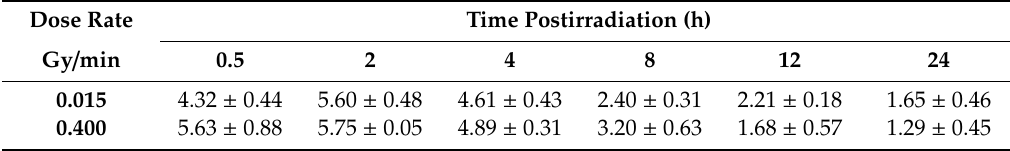
Table 3. Repair kinetics for γ -H2AX foci following exposure to 1 Gy of HDR (0.400 Gy/min) and LDR (0.015 Gy/min) neutrons. All data represent the mean values obtained for four different donors. Dose Rate Time Postirradiation (h) Gy / min 0.5